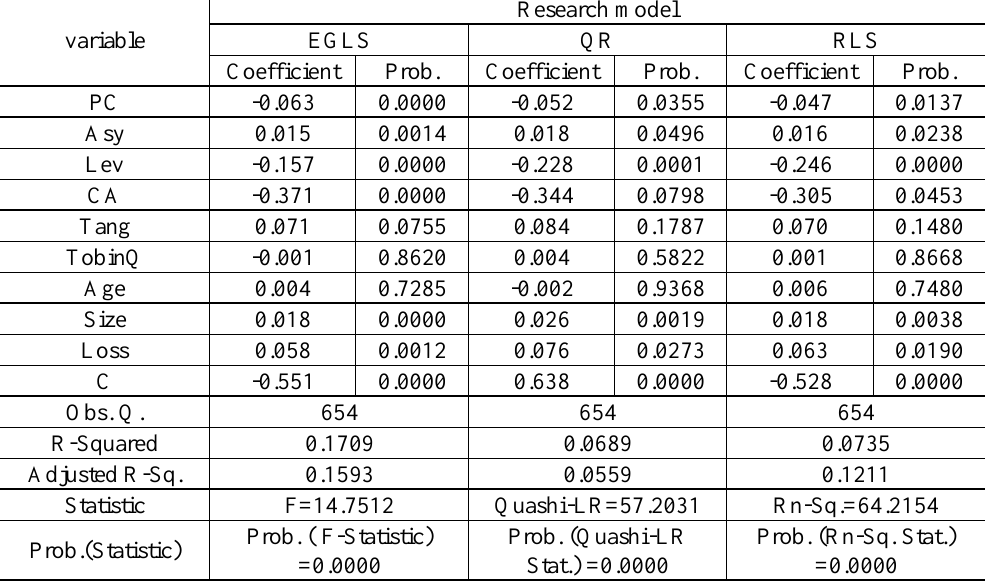
Table 6. Robust Test results of the first, second and third